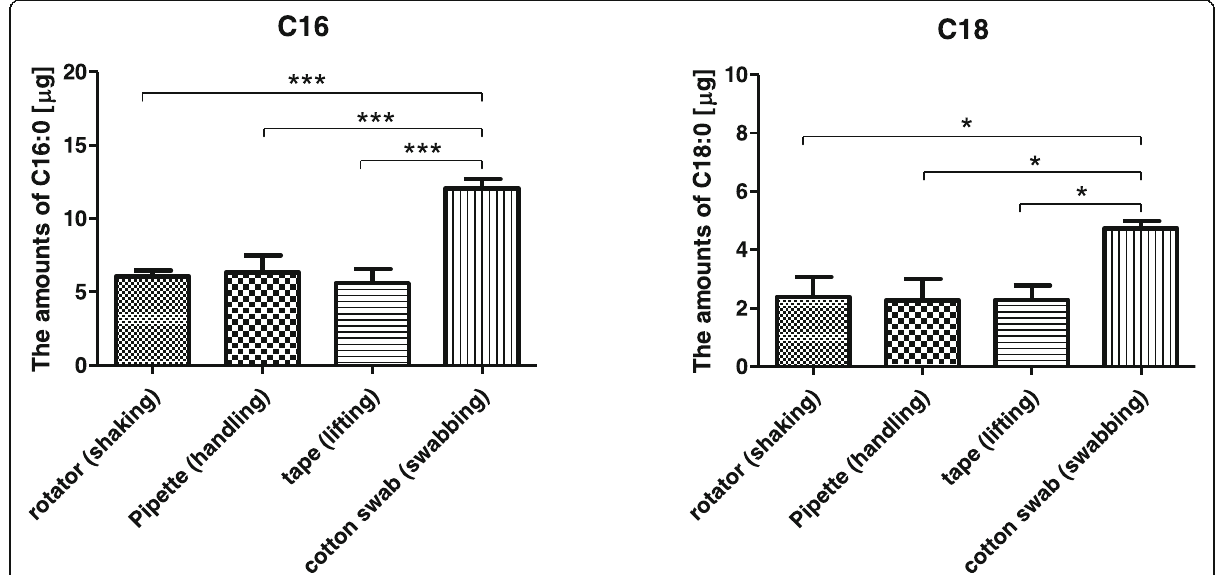
Fig. 11 Total quantity of C16 and C18 by using different treatment methods ( μ g of total fatty acids, n = 8, all donors). Data are represented as means ± SEM. The three asterisks, two asterisks, and one asterisk indicate 0.0001 ≤ p < 0.001, 0.001 ≤ p < 0.01, and 0.01 ≤ p < 0.05. “ No SD ” means there is no significant difference